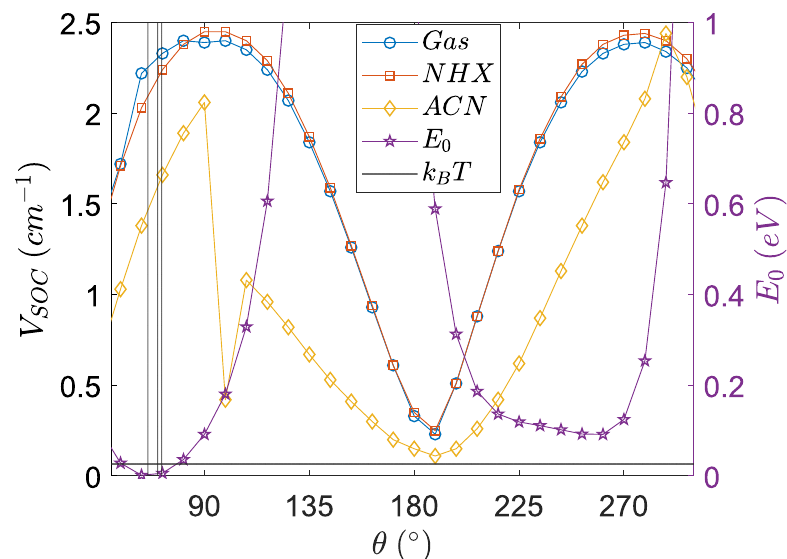
Figure 10. The SOCME values for the singlet charge transfer state 1 CT as a function of dihedral angle starting with the optimized S 1 geometry (TZP/PBE) in different solvents for the whole intact PyrDMA molecule. Weak solvent effects are observed for n-hexane and the gas-phase; however, the dependence is modulated in ACN. Black vertical lines indicate the angles at the optimized geometries of the S 1 state. The quantities are calculated with the TZP basis and the CAMY-B3LYP functional at its default parameters. The ground state energy in NHX (E 0 ) of the intact molecule alongside the thermal energy ( k B T ) is plotted to indicate the important range of conformations. Note that the x -axis ranges from 45 to 300 degrees.